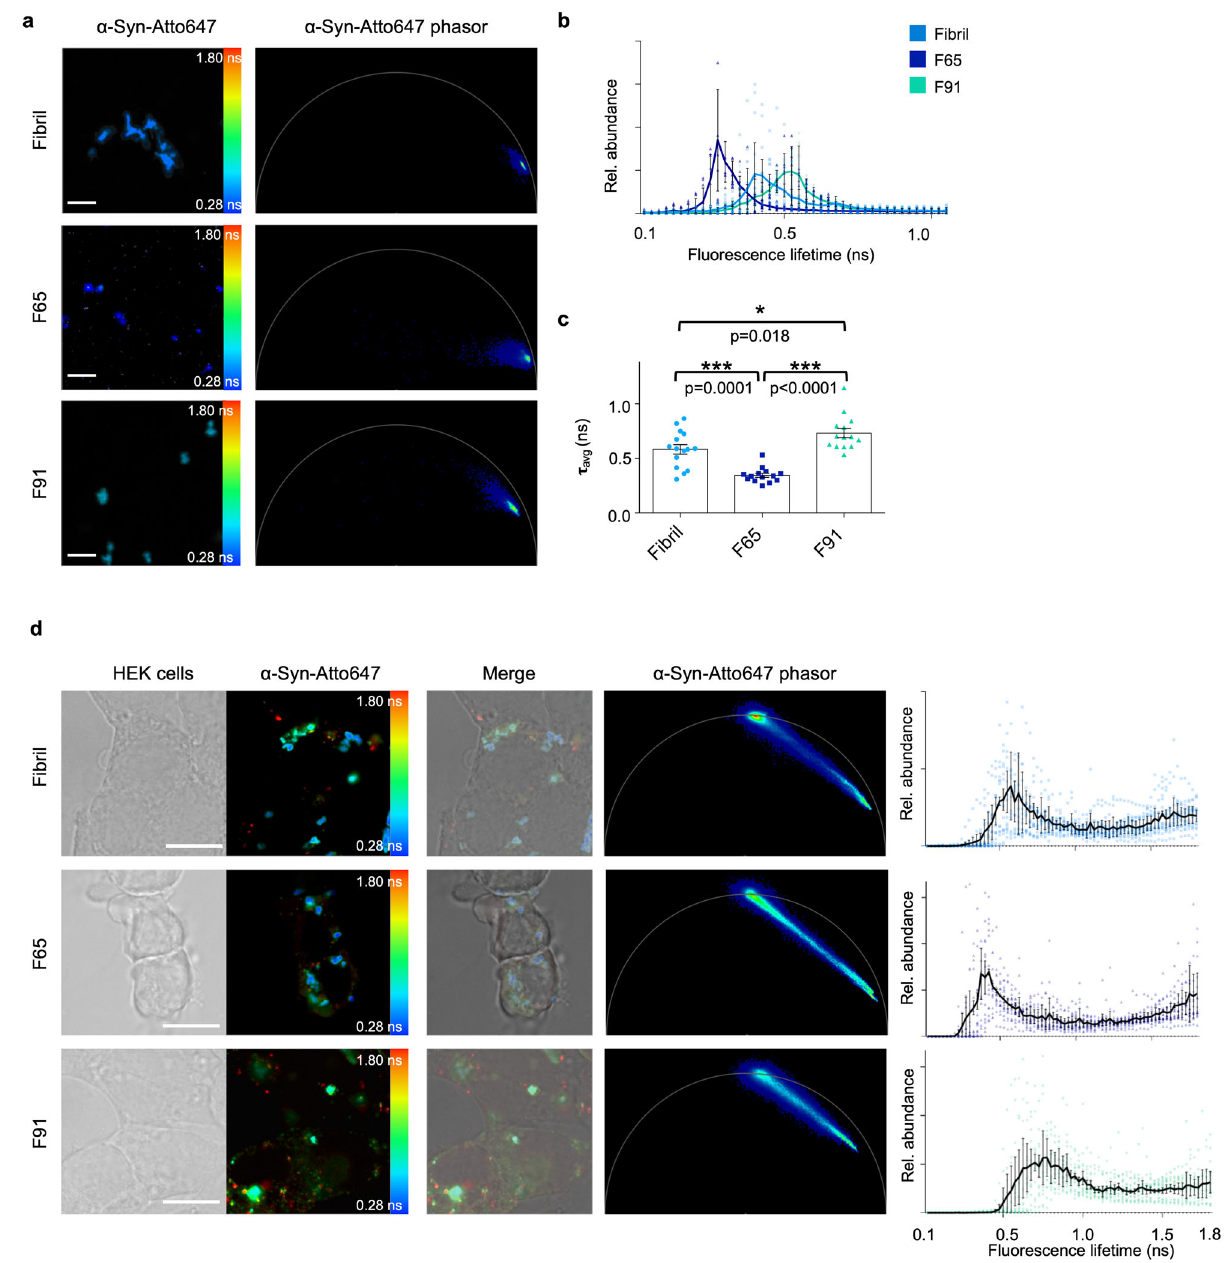
Fig. 3 The cellular environment affects the lifetime distribution of α -Syn polymorphs. a Fluorescence intensity image of α -Syn-Atto647 seeds pseudo colored from blue (0.28 ns) to red (1.8 ns) to illustrate short (blue) and long (red) fl uorescence lifetimes and the corresponding phasor plots when not added to cells. b Histograms of Fibril, F65, and F91 seeds showing the relative abundance (rel. abundance) of pixels with a certain fl uorescence lifetime, averaged over all acquired images ( n = 15 for each polymorph, mean ± SEM). c The mean fl uorescence lifetime ( τ ) of α -Syn polymorphs. Data are shown as mean ± SEM. Statistical analysis was done using one-way ANOVA with Turkey ’ s multiple comparison test. Each α -Syn polymorph shows a signature fl uorescence lifetime distribution and mean. Scale bar, 5 µ m. d Transmitted light image of HEK293 cells and fl uorescence intensity image of pseudo colored α -Syn-Atto647 seeds when added to cells with the merged image and the corresponding phasor plot of the fl uorescence lifetime. α -Syn polymorphs still exhibit a characteristic broadening of lifetime distribution when added to HEK cells not expressing α -SynA53T-YFP. Histograms of α -Syn-Atto647 seeds showing the relative abundance (rel. abundance) of pixels with a certain fl uorescence lifetime (ranging from 0 to 1.8 ns), averaged over all acquired images ( n = 15, mean ± SEM). Scale bar, 10 µ